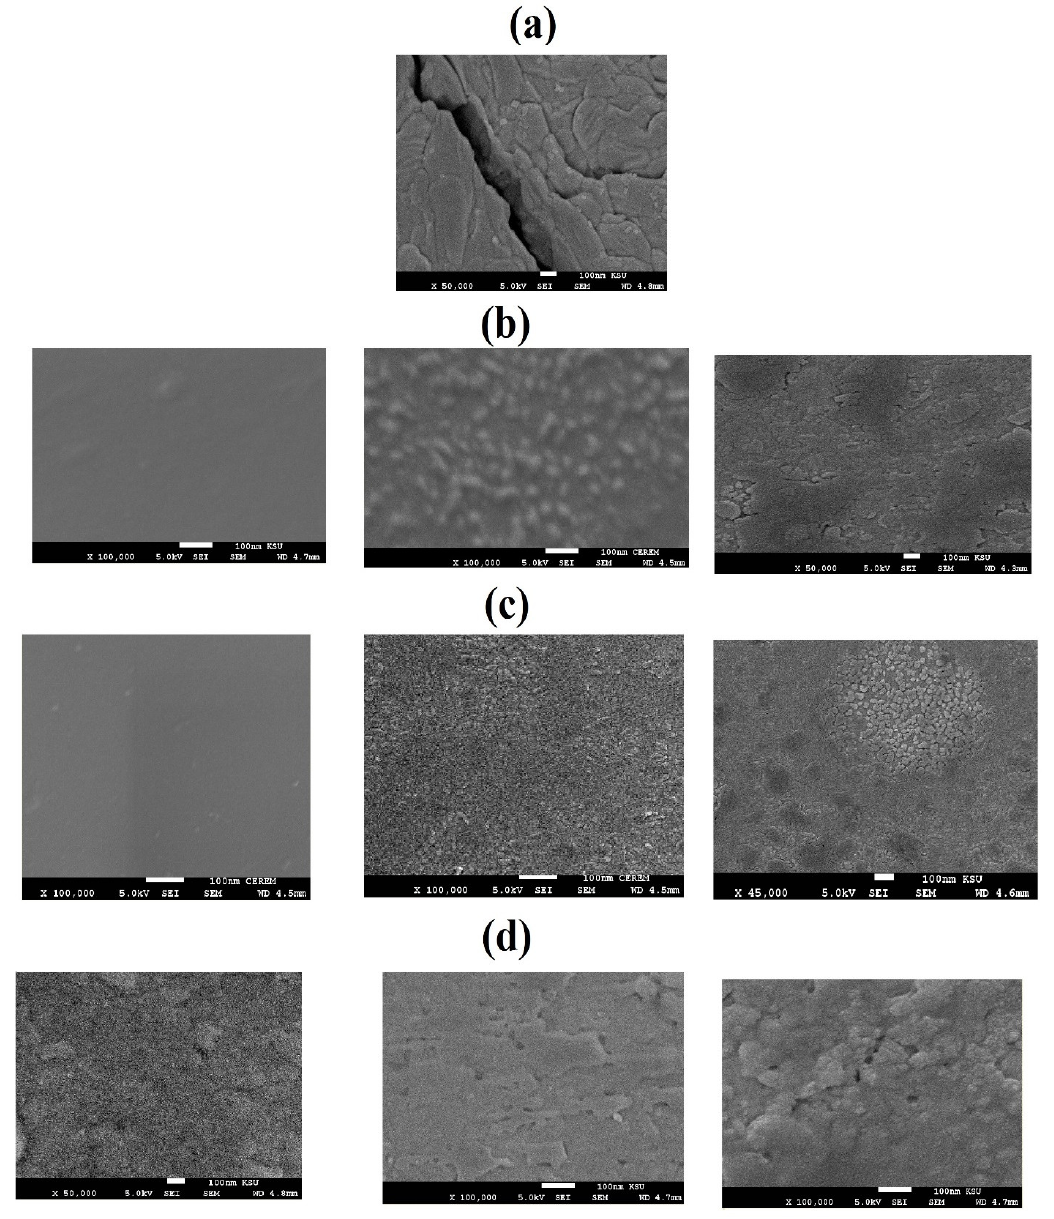
Figure 9. SEM micrographs of fractured cured DGEB/PA films using different wt % from left to right 1, 3 and 10 wt % of Fe 3 O 4 NPs capped with ( a ) blank, ( b ) EOA, ( c ) ELOA and ( d ) ELNA.